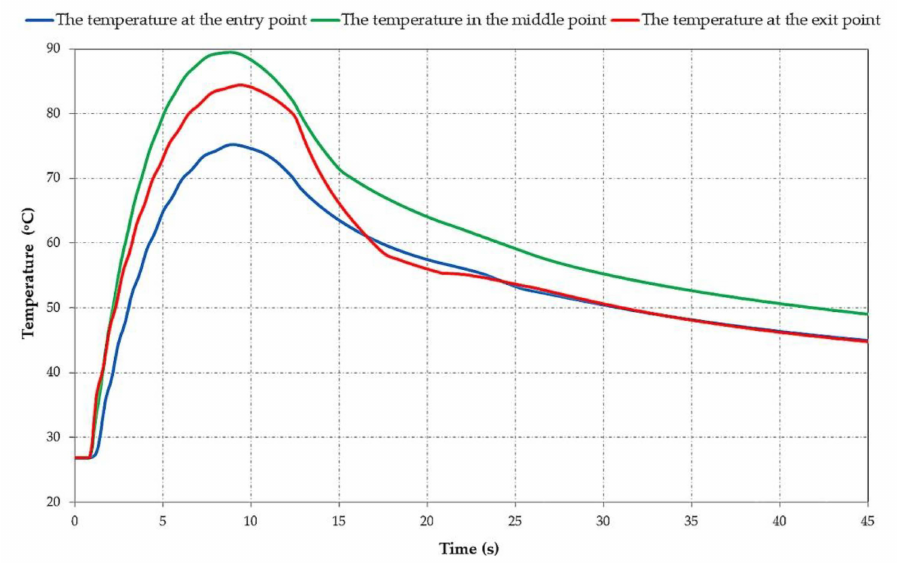
Figure 7. Variation in time of the drum lining surface temperatures for the three